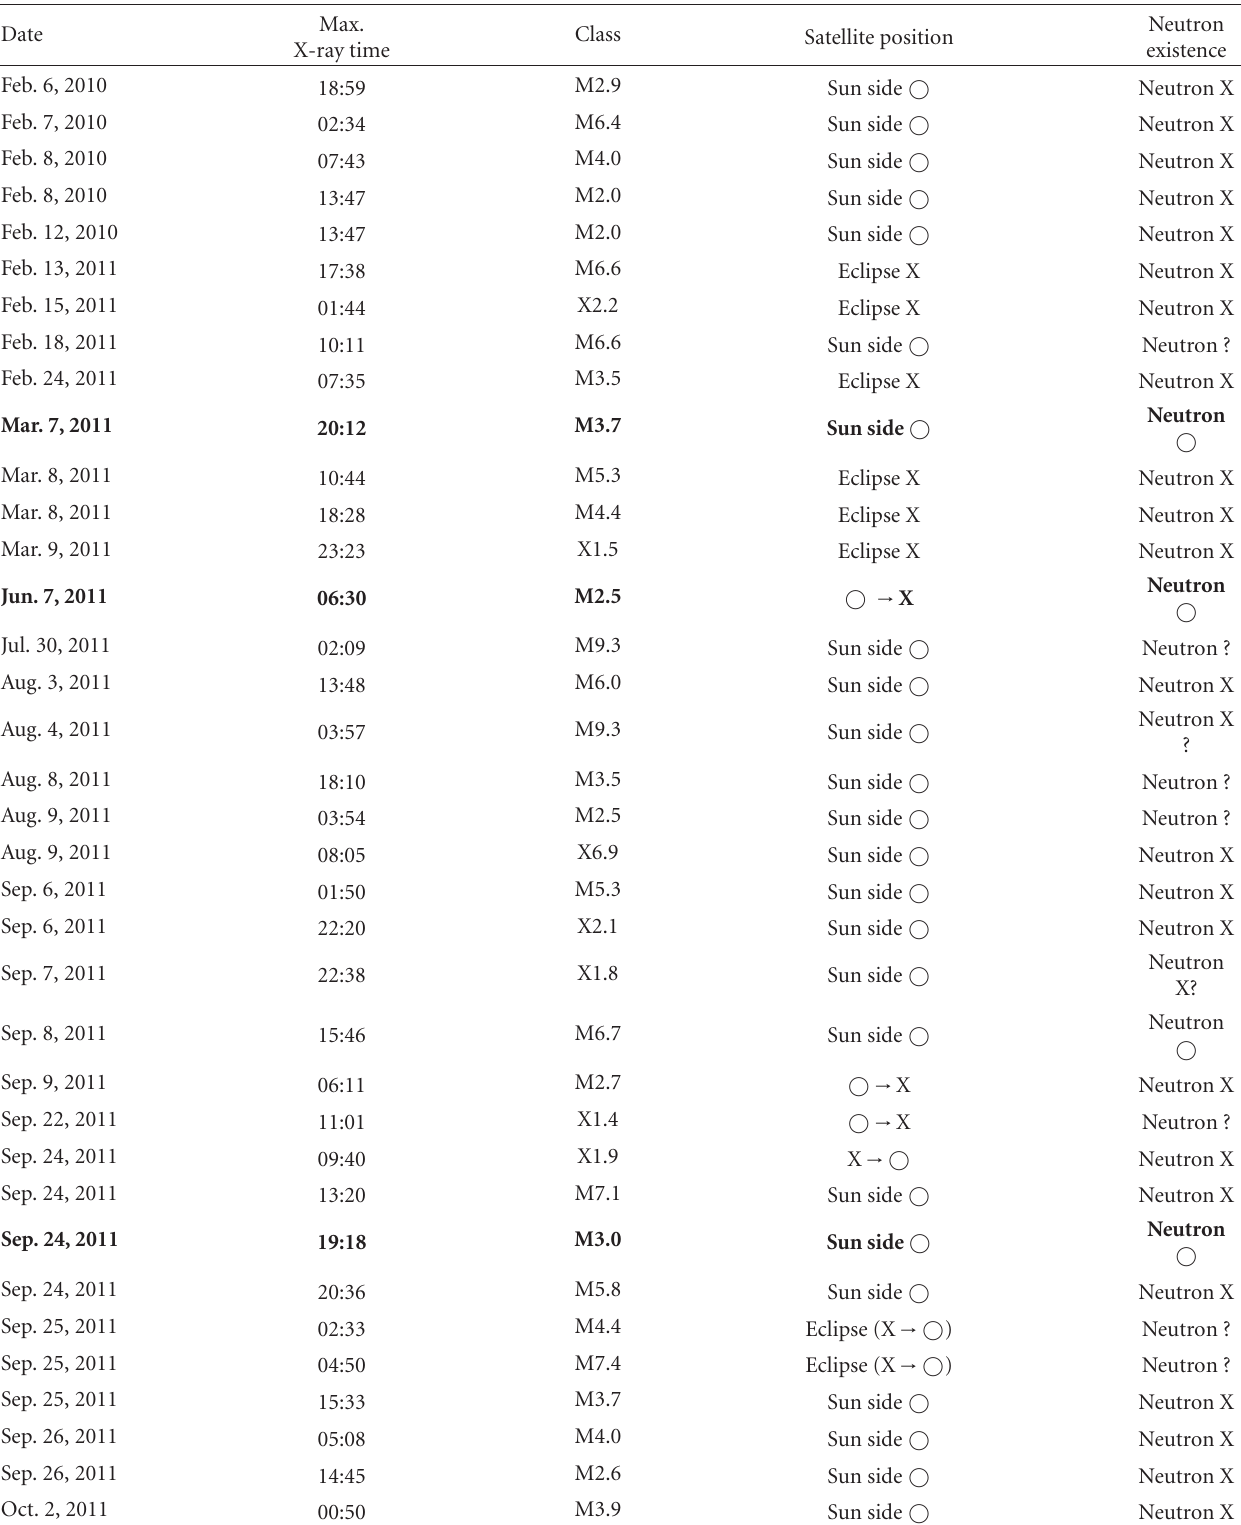
Table 1: The list of solar flares with X-ray intensity exceeding X > 2.0. The first to third columns of Table 1 correspond to the event date, maximum time of X-ray intensity, and flare size, respectively. The fourth column indicates the ISS location regarding whether on the shadow or sunny side of Earth (X or (cid:3) ). The fifth column indicates whether solar neutrons are involved in the data. The (cid:3)→ X and X →(cid:3) notations in the fourth column indicate that the ISS was moving from the sunny side to the shadow side or vice versa 30 minutes from the peak flare time. The ? mark of the fifth column indicates a possible neutron event with statistical significance of less than 3 σ